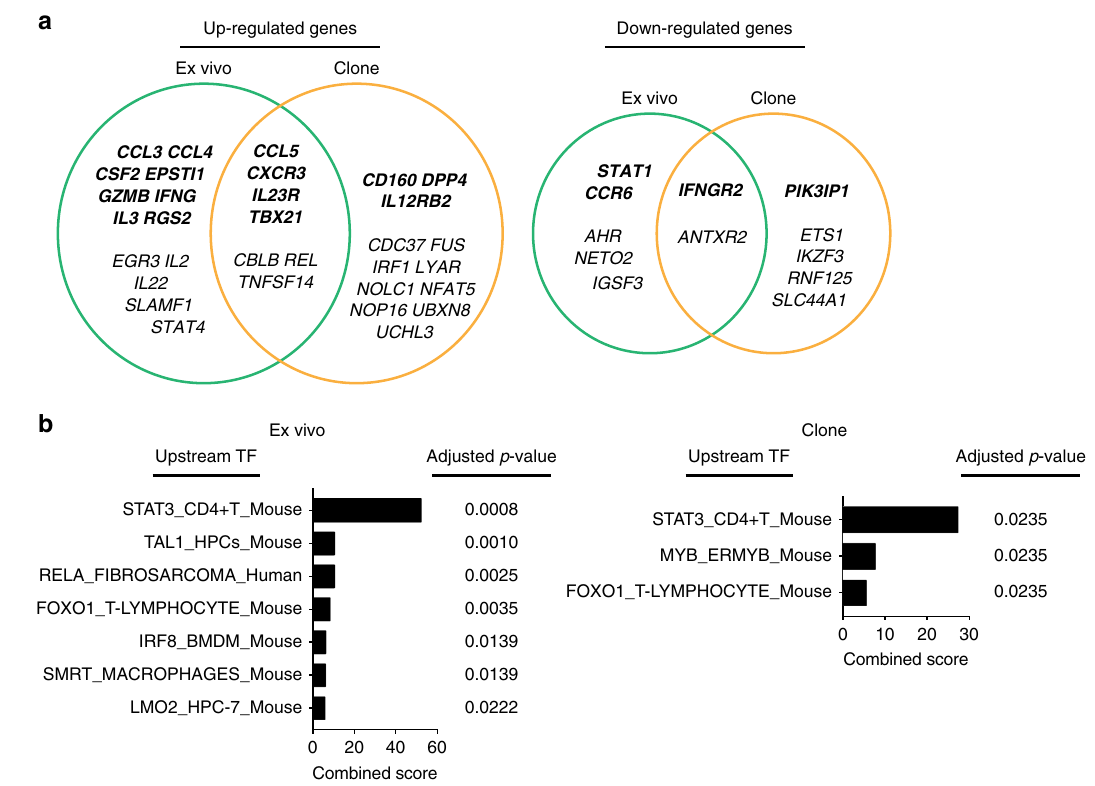
Fig. 4 Predicting STAT3 as upstream transcription factor by the PreP-Signatures of T H 17 cells. a Venn diagram representations of signature genes upregulated (left) and downregulated (right) in human T H 1/17 cells and IL-10 – T H 17 clones. Complete PreP-Signatures from GSEA comparison Scenarios I and II were merged for ex vivo cells (Fig. 2b, c) and T H 17 clones (Fig. 3d, e), respectively. Genes with supervised absolute fold change > 1.5 in either ex vivo cells or T H 17 clones were shown in italic bold letters. Ex vivo, differentially expressed “ leading edge ” genes from T H 1/17 vs. T H 17 GSEA comparisons presented in green circles; Clone, differentially expressed “ leading edge ” genes from IL-10 – vs. IL-10 + T H 17 clone GSEA comparisons presented in yellow circles. b Predicted upstream transcription factors for T H 1/17 and IL-10 – T H 17 clone differentiation. The molecular signatures of T H 1/17 cells and IL-10 – T H 17 clones in a were analyzed using the Enrichr ChEA2016 analysis and the predicted transcription factors with Benjamini – Hochberg adjusted p -value < 0.05 were shown. TF transcription factor